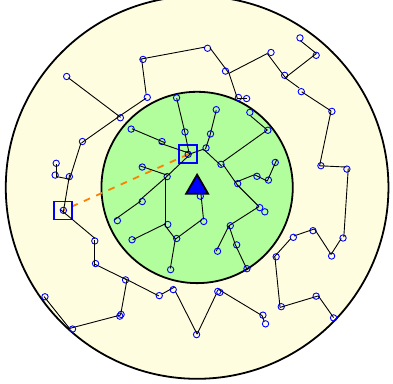
Figure 11. Network topology after all wedges are merged.